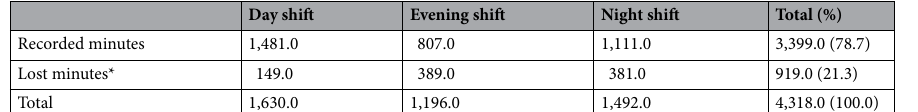
Table 1. Video recording information. *Lost when saving data on the computer or a failure to record because of device error.